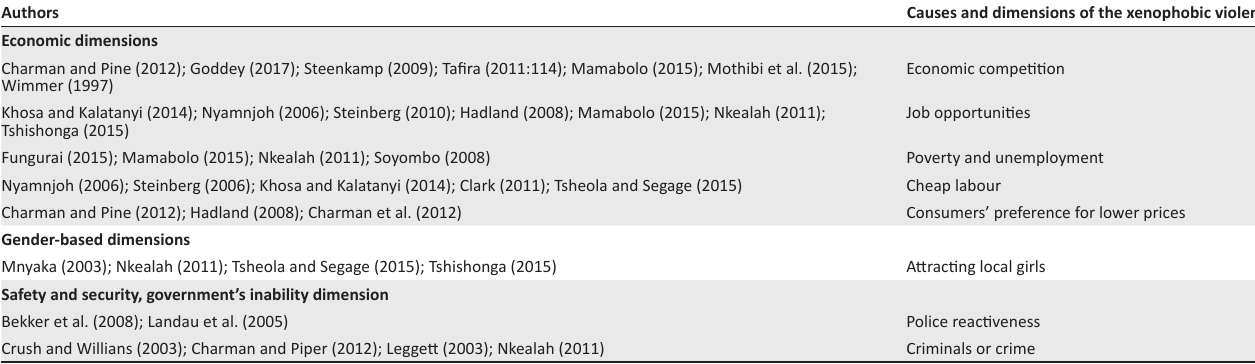
TABLE 1: The causes and dimensions of the xenophobic violence evident in existing literature.